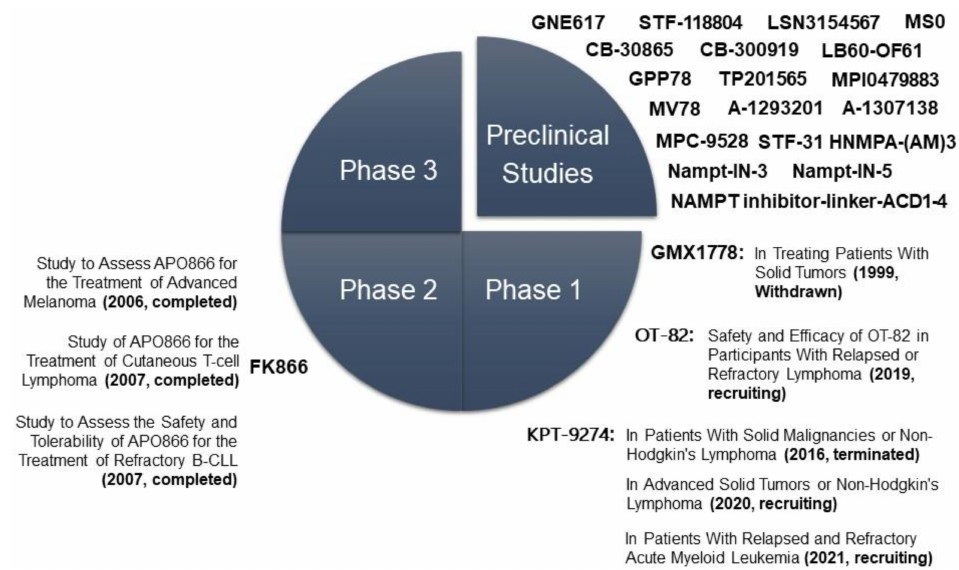
Figure 5. Scheme of the proliferation of NAMPT inhibitors in preclinical or clinical